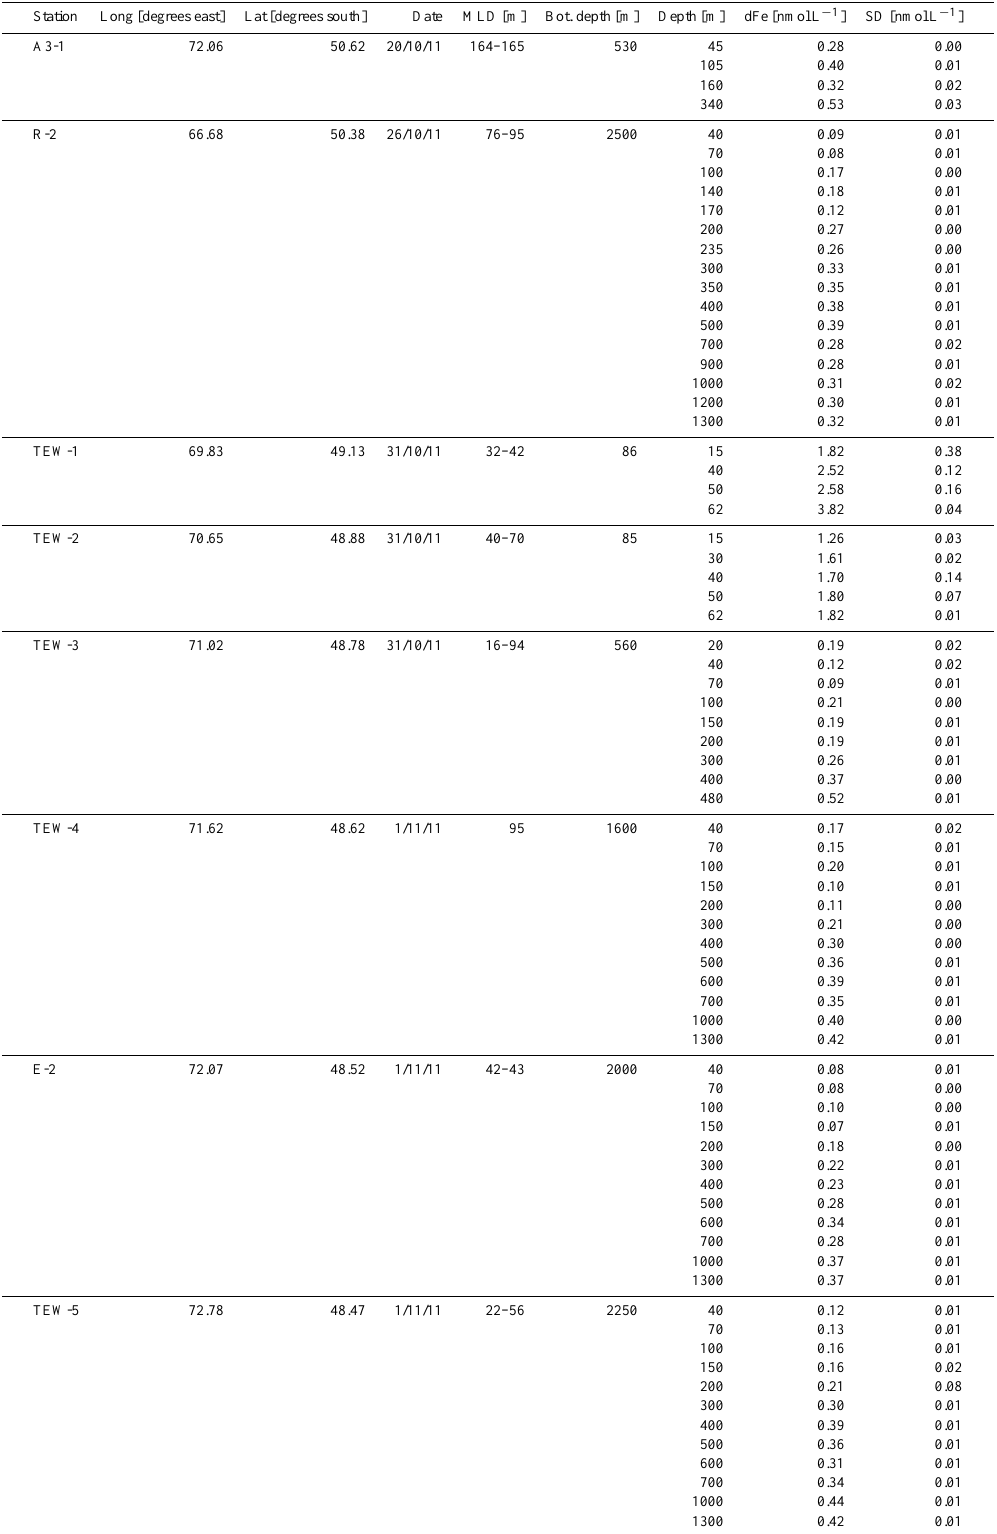
Table 1. Station name, longitude, latitude, sampling date, mixed layer depth (MLD), station bottom depth, location, dissolved iron concen- trations (dFe), and standard deviation (SD) during KEOPS2. MLD were estimated using, as a reference, potential densities at both 10 and 20m. When estimates are different, both values are